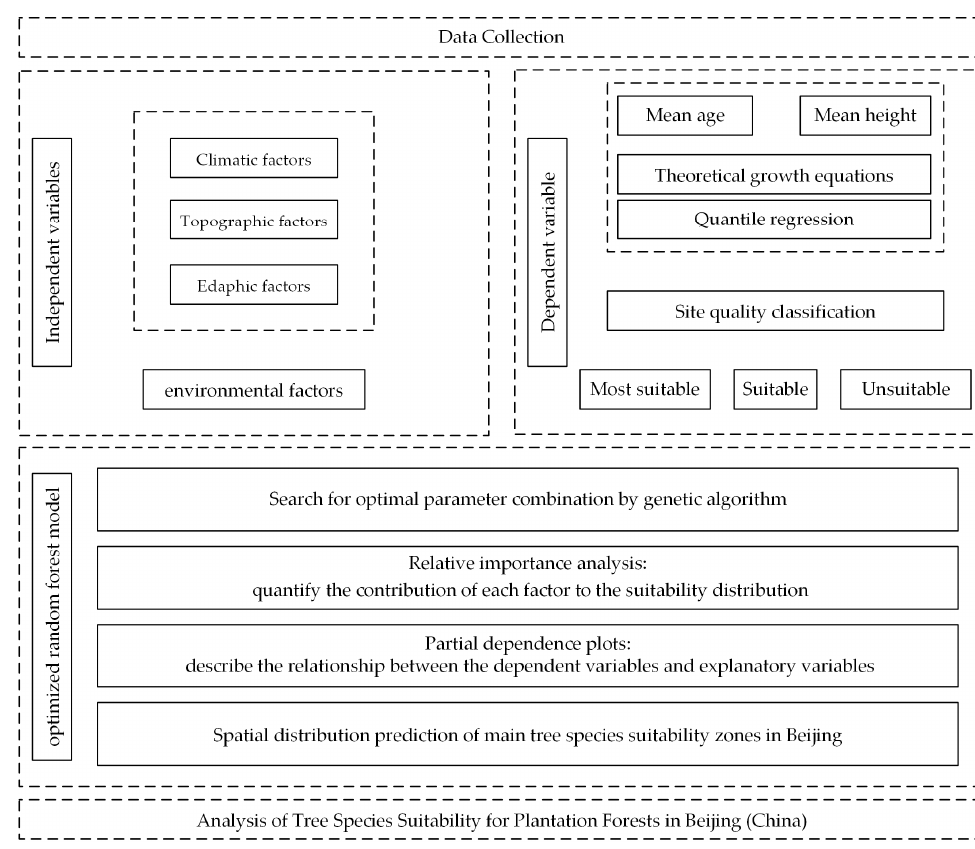
Figure 2. Technical framework diagram for this study.